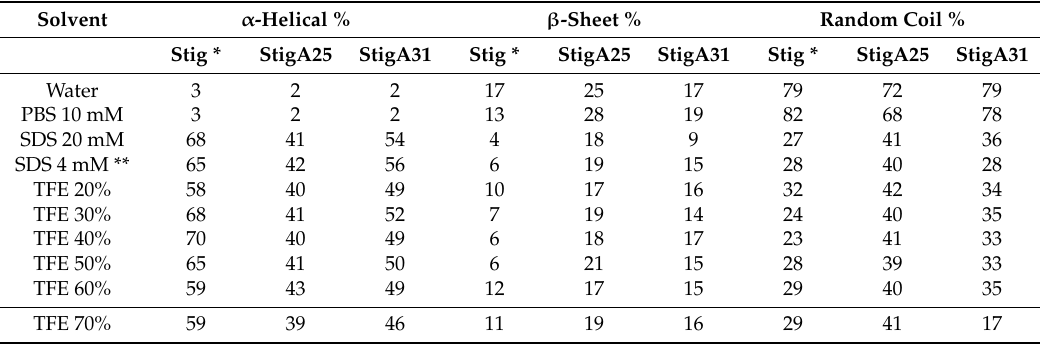
Table 2. Secondary structure percentage of Stigmurin, StigA25, and StigA31 obtained by CD.